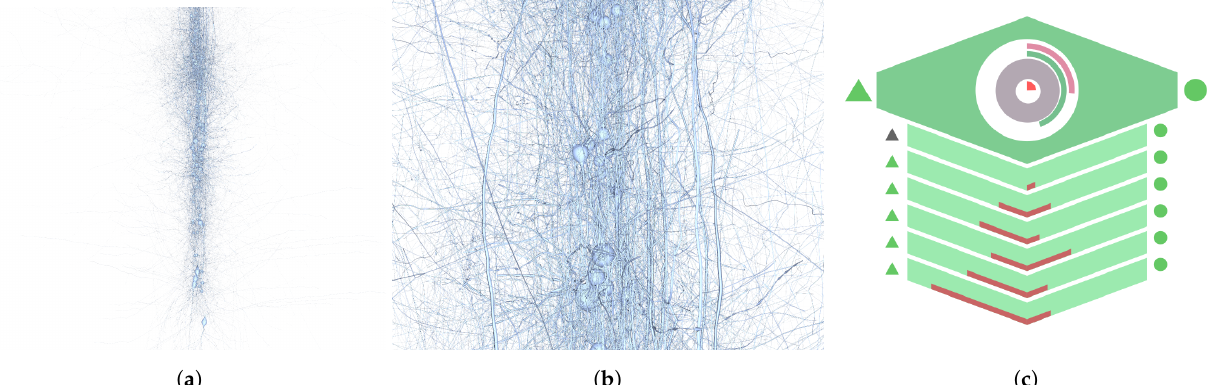
Figure 5. Visualization of a microcolumn. ( a ) Realistic representation: far view; ( b ) realistic representation: closeup view; ( c ) abstract representation.